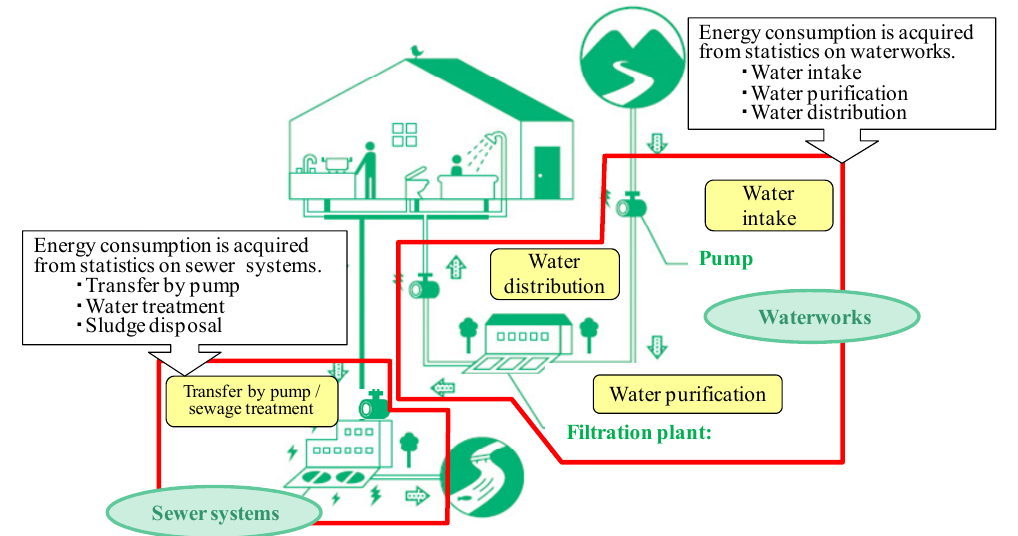
Figure 2. Calculation boundary for CO